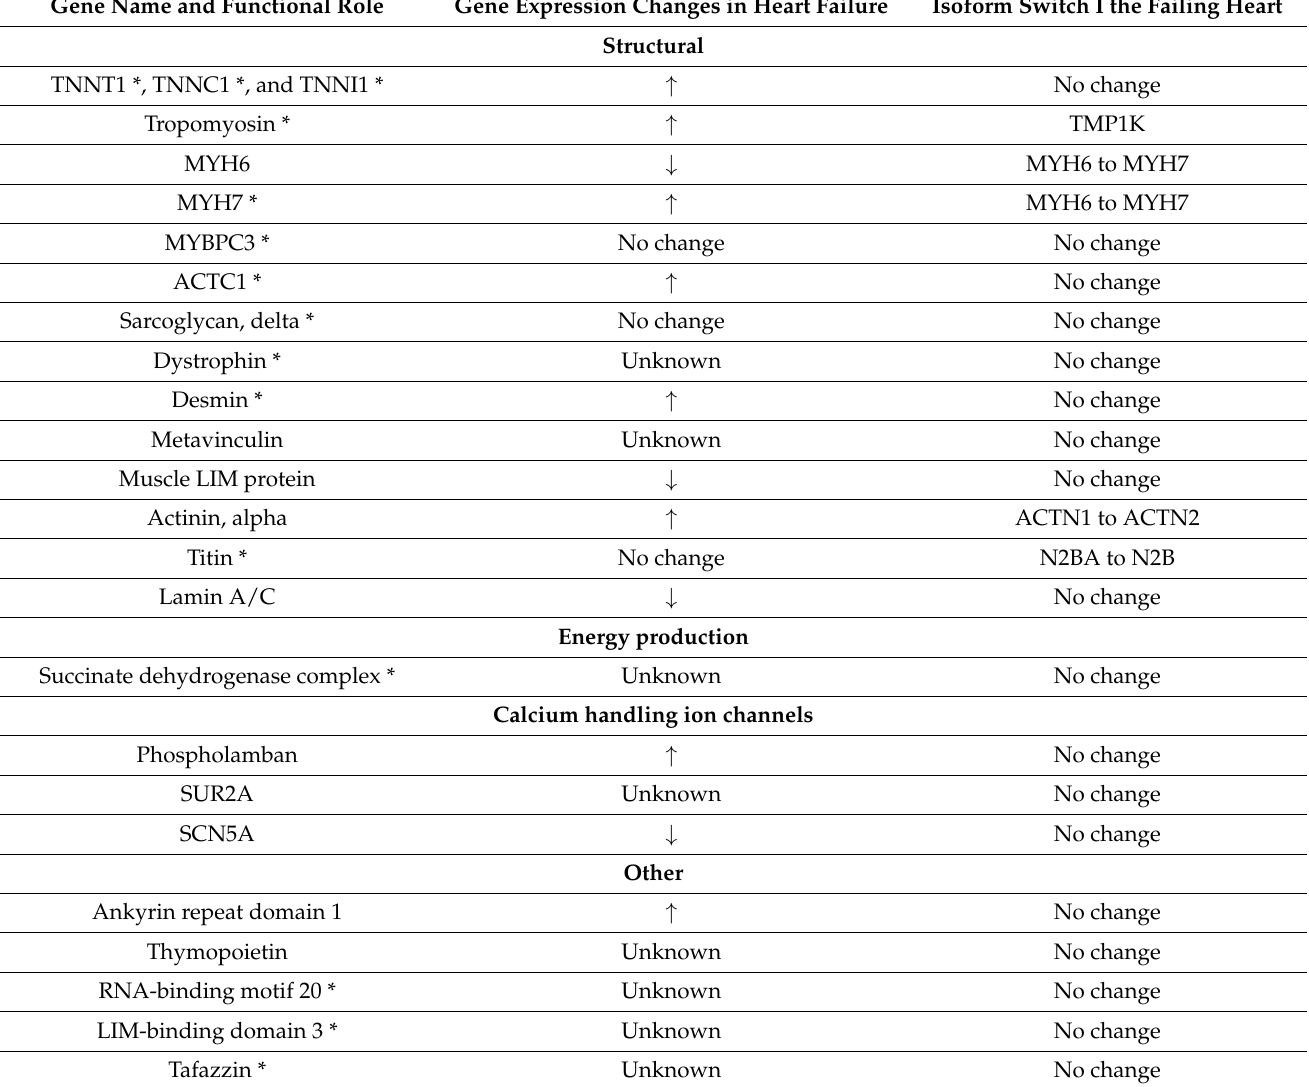
Table 1. Changes in gene expression and their functional role in the failing